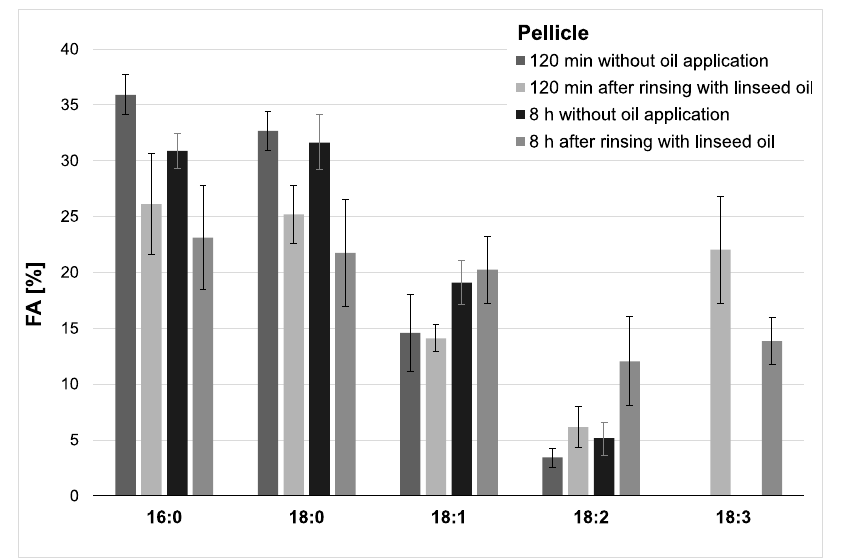
Figure 2. Percentage of the four major fatty acids and linolenic acid (18:3) in the pellicles. Measure- ments were performed after 2 h or 8 h of pellicle formation, either with or without linseed oil ap-